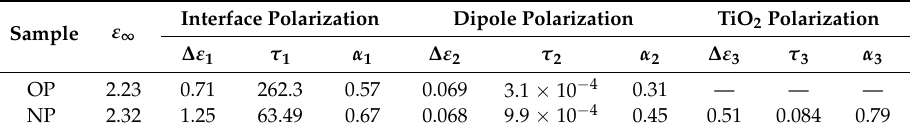
Table 2. Estimated multiple relaxation Cole-Cole model parameters of OP and NP.